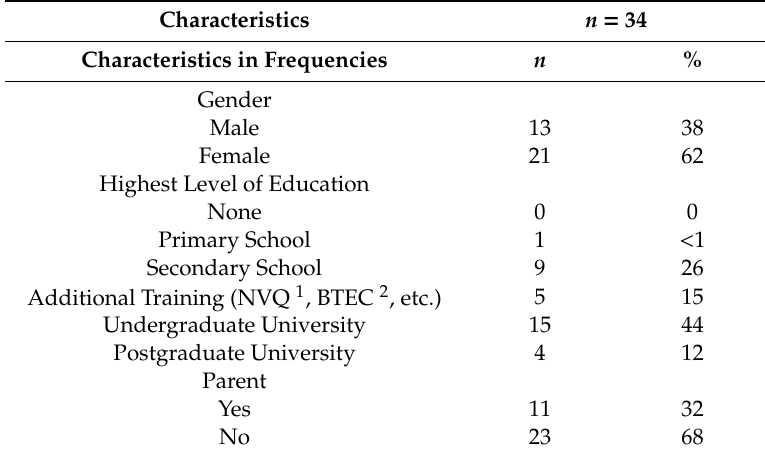
Table 3. Characteristics of focus group participants, n =